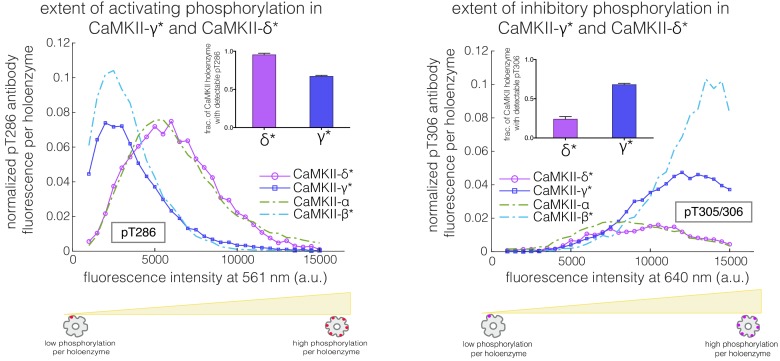
Autophosphorylation status of activated CaMKII-γ* and CaMKII-δ*.Comparison of the extent of autophosphorylation (intensity histogram) among CaMKII-γ*, CaMKII-δ*, CaMKII-α, and CaMKII-β* holoenzymes at the activating site (Thr 286) (left panel) and the inhibitory site (Thr 305/306) (right panel). The insets show the fraction of holoenzymes that exhibit any detectable phosphorylation for the corresponding phosphosite in CaMKII-γ* and CaMKII-δ* (see Materials and methods for details of normalization).